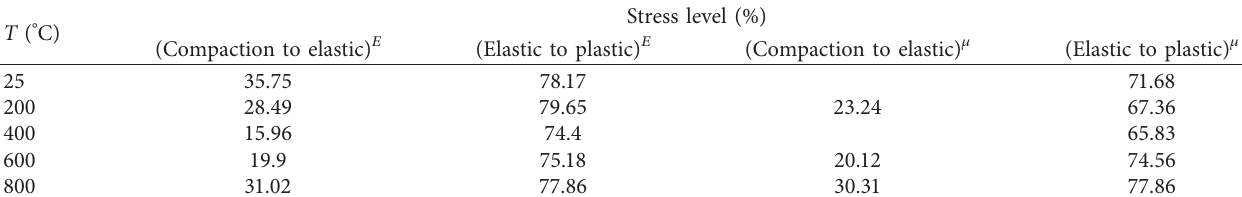
Table 4: Statistics of the incremental ratio of deformation parameters to axial pressure